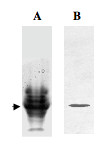
Production of SASPs by cpe-positive C. perringens. (A) SASPs, prepared from a representative C. perfringens food poisoning isolate SM101, was separated by polyacrylamide gel electrophoresis at low pH and stained with Coomassie brilliant blue. (B) Western blot of the gel shown in panel A. The blot was probed with antibodies against B. subtilis SspC [13] and developed by chemiluminescence detection to identify immunoreactive species. Arrow indicates the major band that was immunoreactive with B. subtilis SspC antibody.